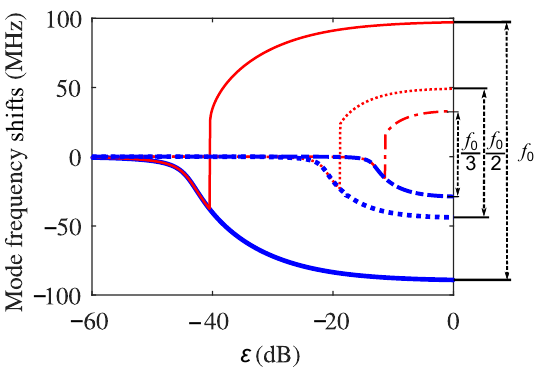
Figure 7. The fundamental (blue) and higher-order (red) solutions of the excess-phase equations by involving the first ECRT (the solid lines), the second ECRT (the dotted lines), and the third ECRT (the dashed dotted lines) separately in the THz QCL with optical feedback, where L ext = 0.8 m.